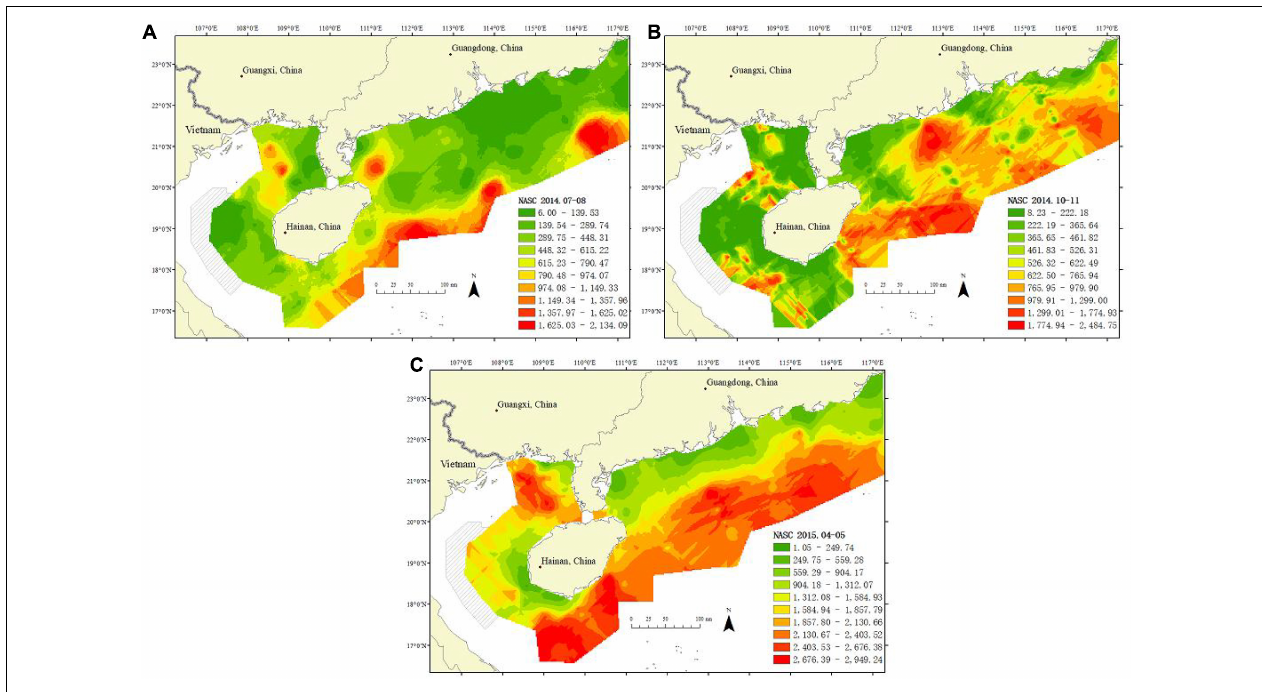
FIGURE 6 | The temporal and spatial distribution of the nautical area scattering coefficient (NASC). The color green is the lowest, yellow is the middle, and red is the highest. (A) July to August 2014; (B) October to November 2014; (C) April to May 2015.